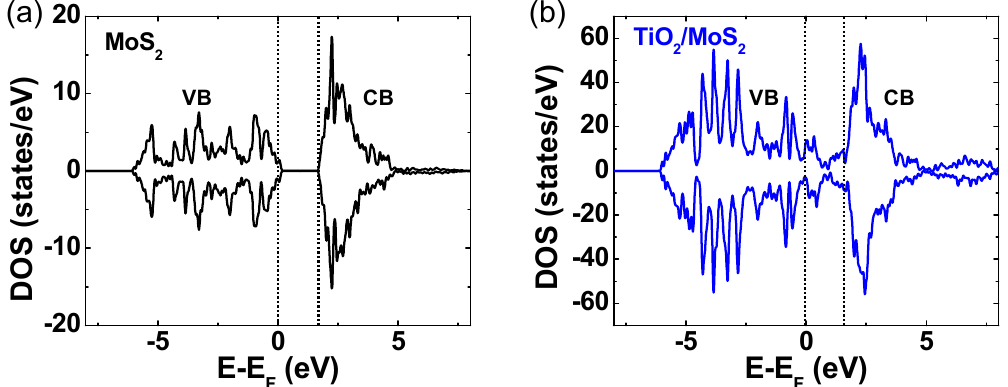
Figure 5. Density function theory (DFT)-calculated density of states (DOS) of ( a ) MoS 2 and ( b ) TiO 2 /MoS 2.